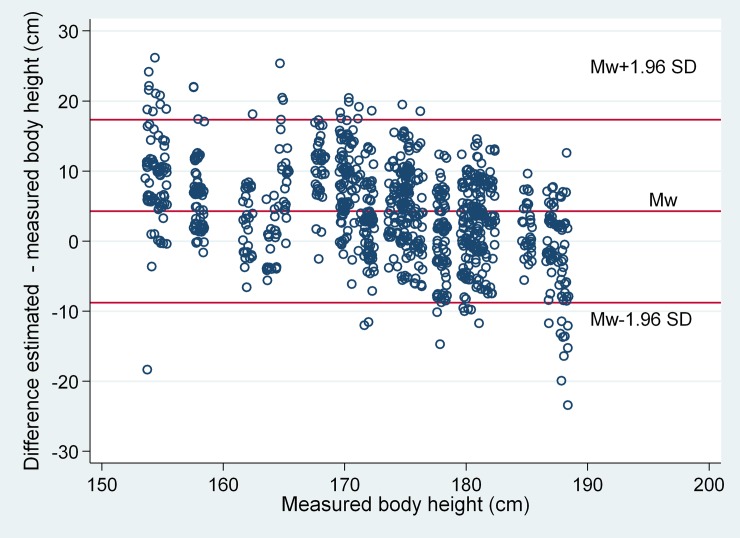
Modified Bland–Altman plot: Each dot represents an estimate of body height.Differences between measured and estimated height (y-axis) are plotted against the true height (x-axis).